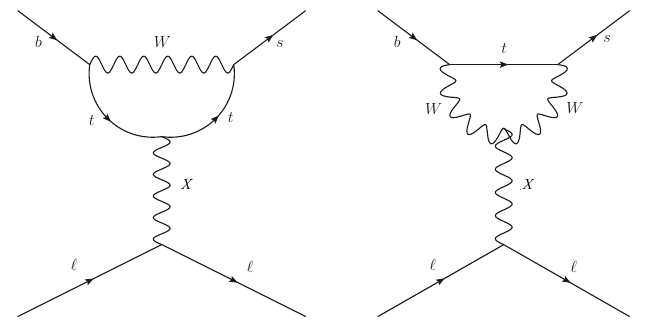
Figure 1 . Dominant diagrams contributing to b → s‘ + ‘ −